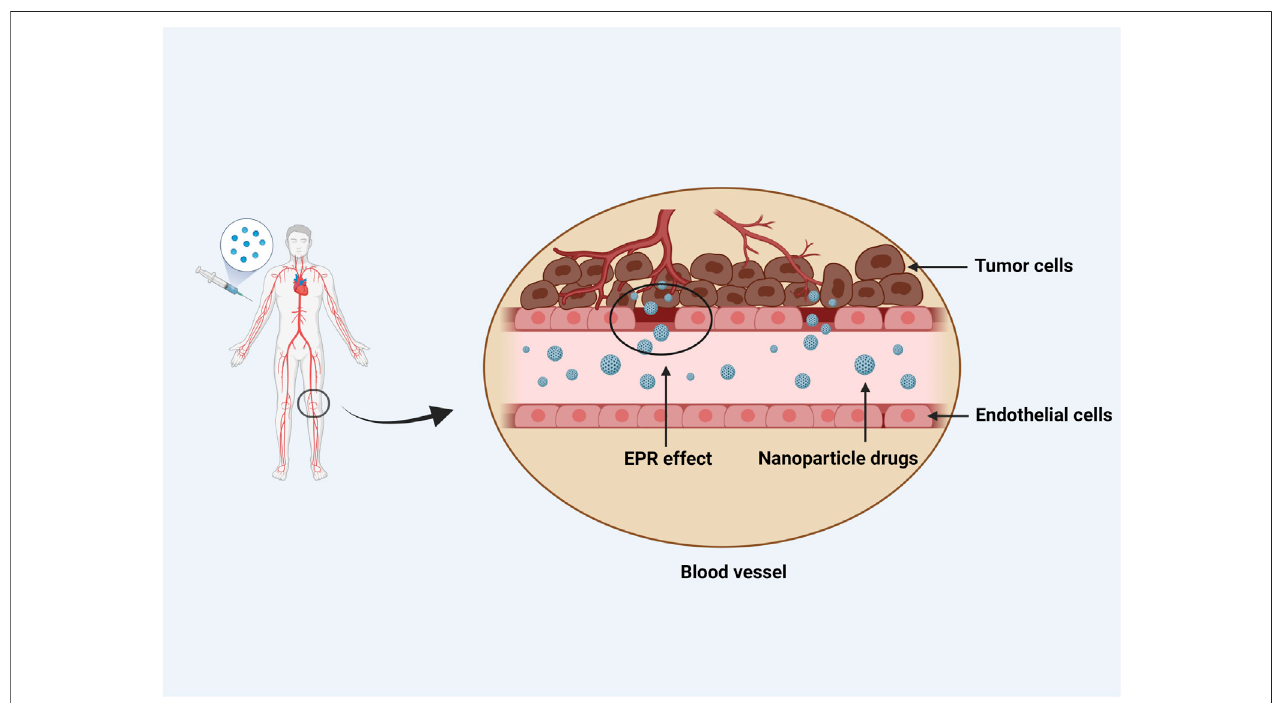
FIGURE 2 | NPs passively target the local environment of tissues. To enhance uptake and accumulation in tumor tissues and in fl ammatory regions, passive targetingdependsoncell-speci fi cfunctionsorlocalconditionsparticulartothetargettissue.Bloodvesselsaboundintumortissues,whichhavelargevascularwallgaps and poor structural integrity. Due to the EPR effect, nanomedicines with a diameter of 10 – 100 nm can be concentrated in tumor tissues. On the contrary, because the microvascular endothelial space in healthy tissue is dense and structurally intact, macromolecules and lipid particles are dif fi cult to penetrate the blood vessel wall, resulting in a decrease in nanomedicine distribution in normal tissues and passive targeting of nanomedicine to tumor